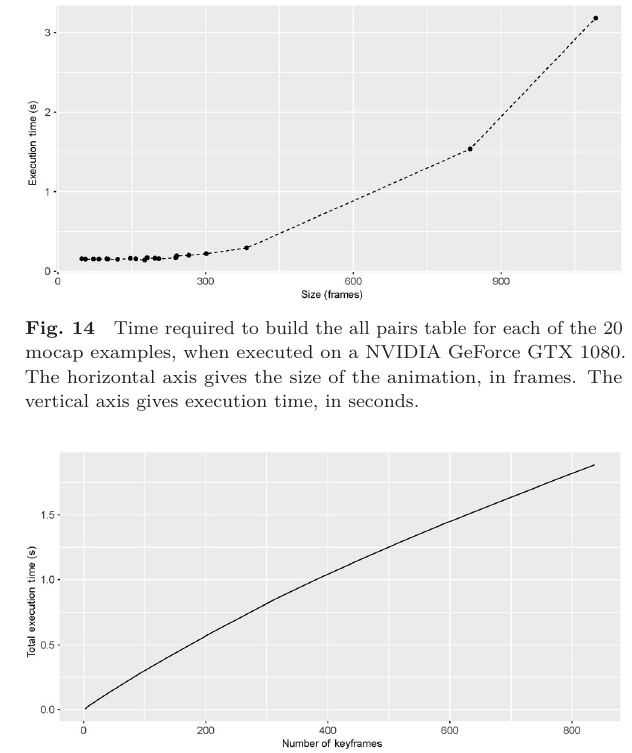
Fig. 15 Time required to compose all solutions for the “Standing With Briefcase” mocap example (837 frames), when executed on an Intel Core i7-8700 @ 3.20 GHz. The horizontal axis depicts the number of iterations (i.e., the number of keyframes selected), and the vertical axis depicts execution time in seconds. After slightly over one second, Salient Poses has computed all selections that correspond to at least 50% compression ( K (cid:2) 417 keyframes).